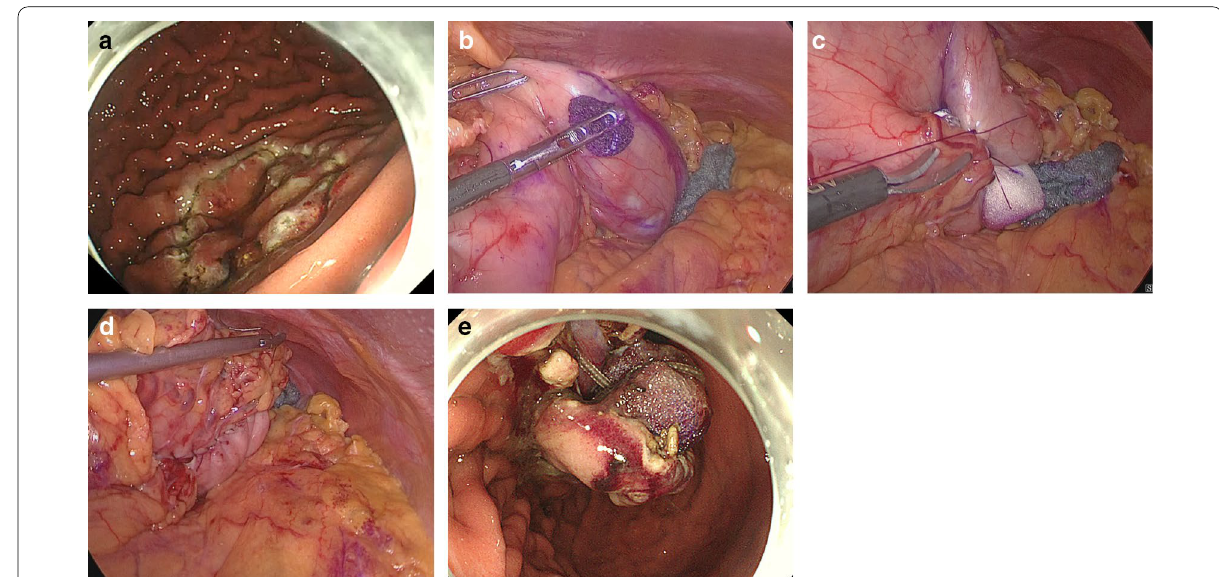
Fig. 2 Procedure for closed laparoscopic and endoscopic cooperative surgery. a Circumferential endoscopic submucosal resection around the tumor. b Laparoscopic serosal marking under guidance by endoscopy. c , d Seromuscular suture with inversion of the marked lesion into the inside of the stomach in such a way to bury a spongy spacer. e Endoscopic seromuscular dissection. The spacer extended the space between the sutured seromuscular plane and the serosal surface of the inverted